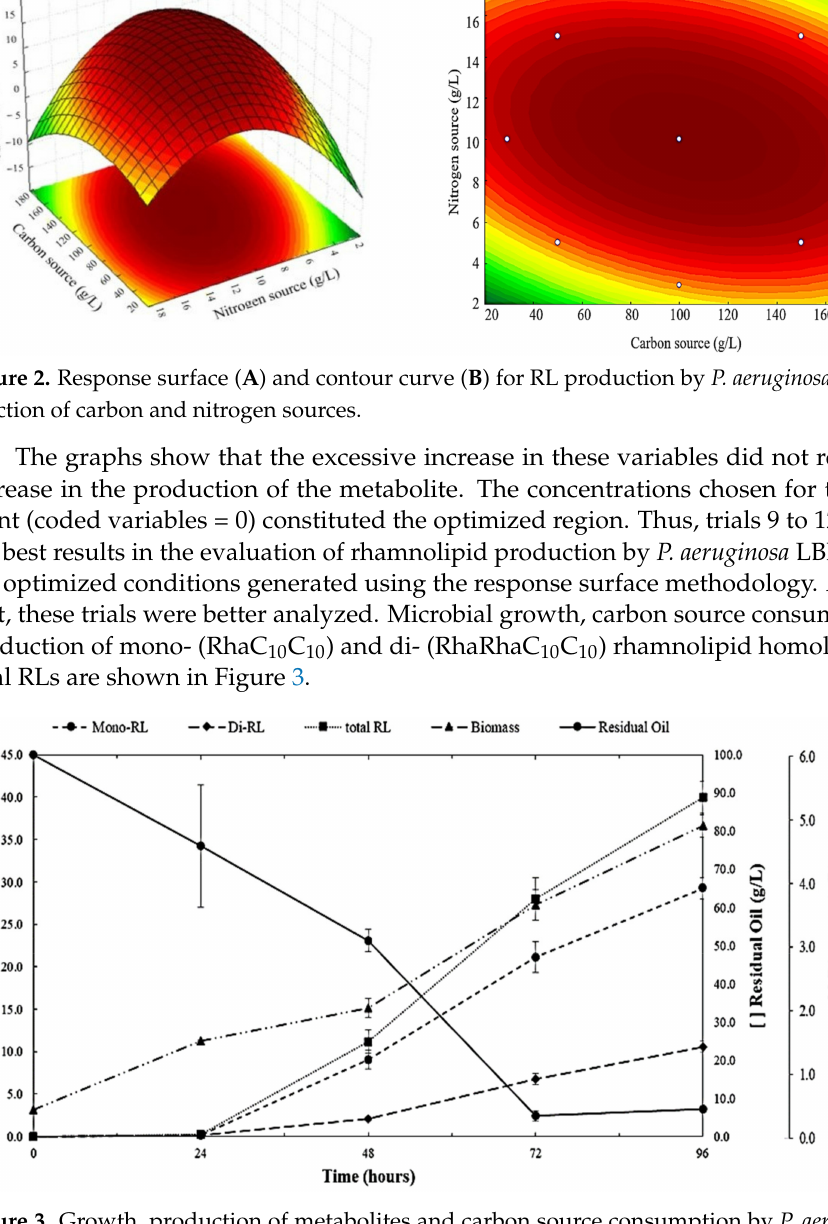
Figure 3. Growth, production of metabolites and carbon source consumption by P. aeruginosa LBI 2A1 in Trials 9–12 (coded variables = 0) of rotational central composite design. Cultivation took place at 200 rpm and 37 ◦ C for 96 h of